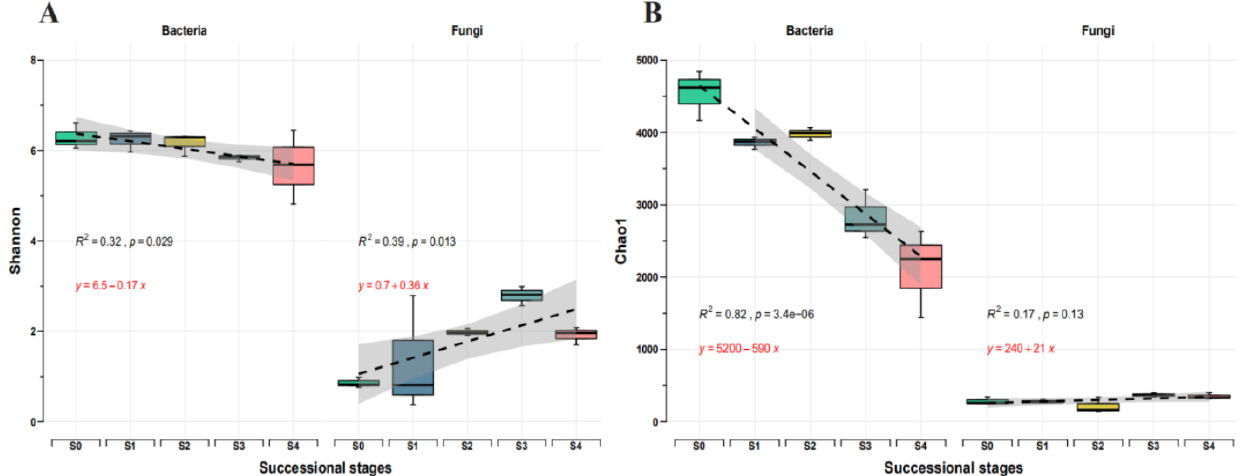
Figure 1. The dynamic changes of microbial alpha-diversity at different successional stages. ( A ) Shannon; ( B ) Chao1; Linear trend is the ordinary least-squares linear regressions; shaded area indicates confidence interval (0.95); S0 to S4 represent successional stages from 0 to 4, respectively.